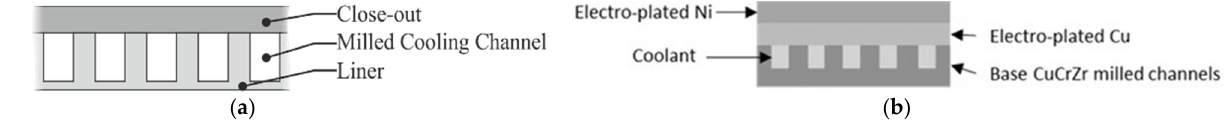
Figure 3. Example of a typical liquid rocket engine (LRE) cooling jacket: ( a ) milled channels brazed onto the external close-out; ( b ) schematics of the electroplating process applied in LRE cooling jacket manufacturing.